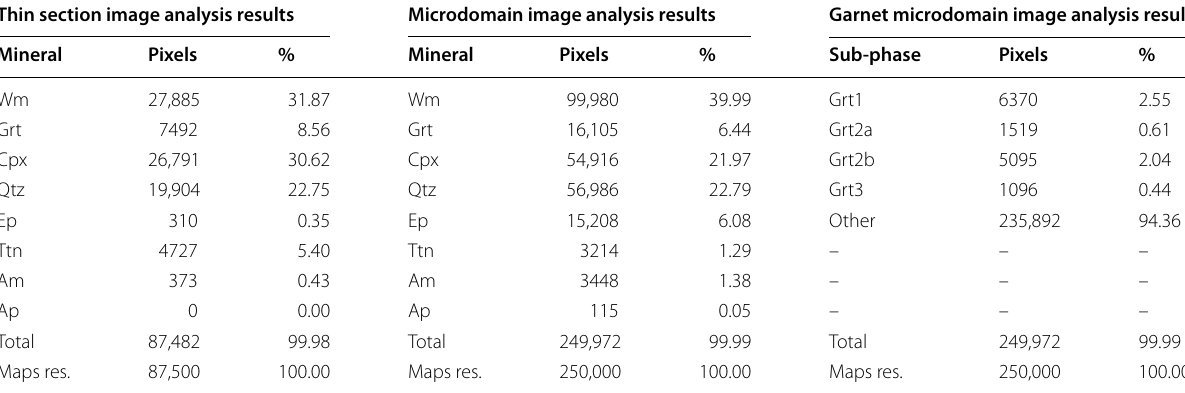
Table 9 Modal percentages of the garnet-bearing gneiss (ZR4) mineral constituents obtained via Q-XRMA